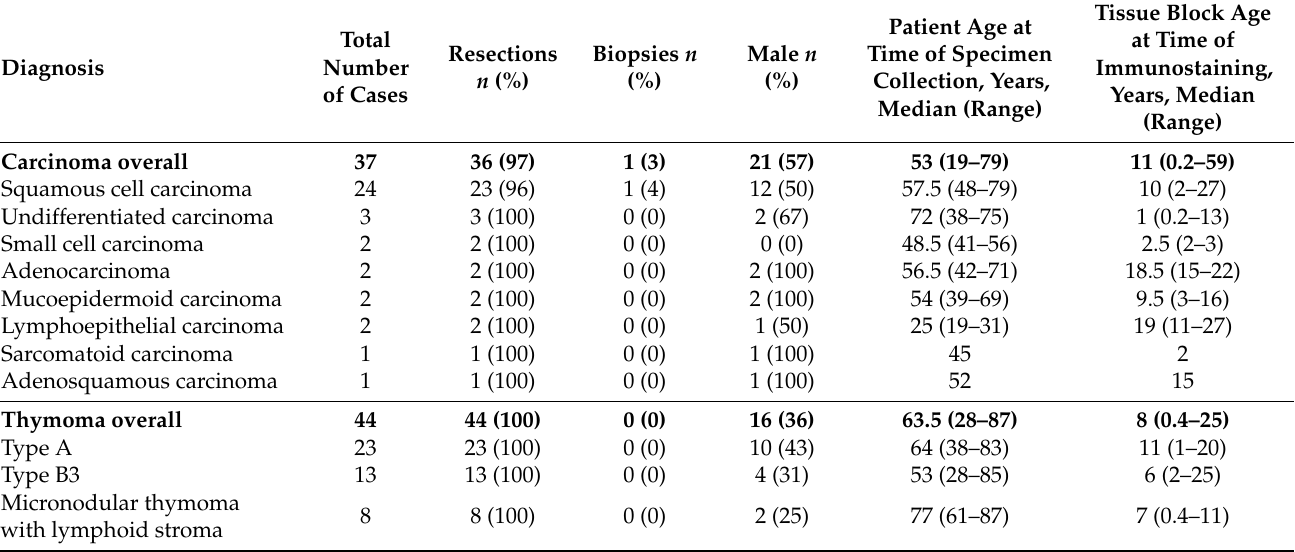
Table 1. Patient demographics and WHO classification of thymic epithelial